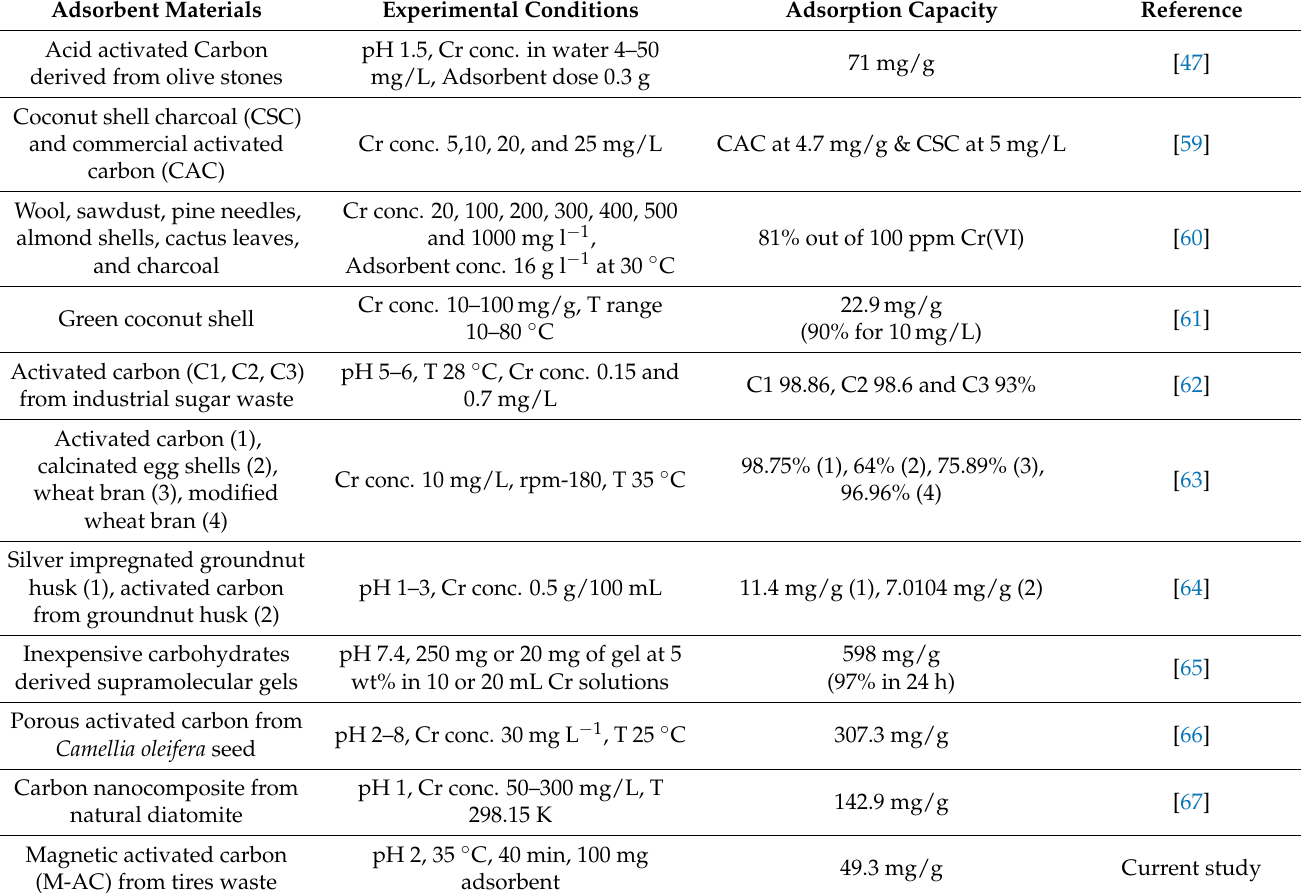
Table 7. Comparison of Cr (VI) adsorption efficiencies of various low-cost